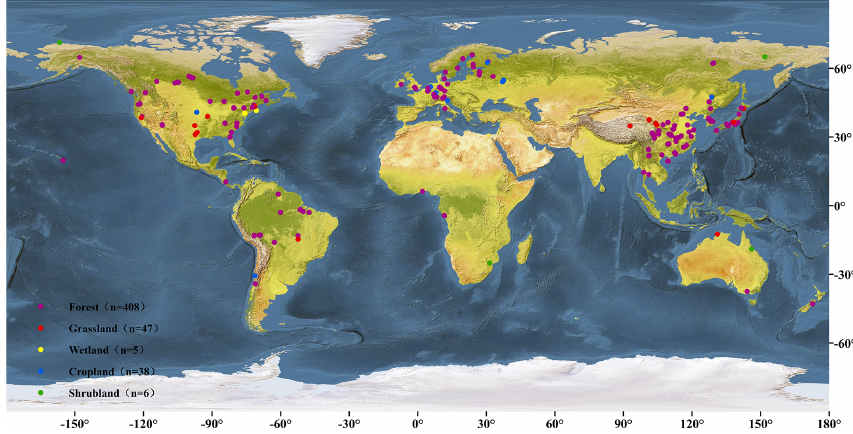
Figure 1. Distributions of the study sites for RH